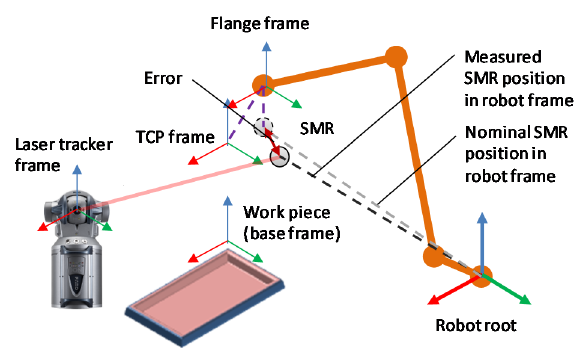
Figure 6. Coordinate frames involved in real-time compensation.